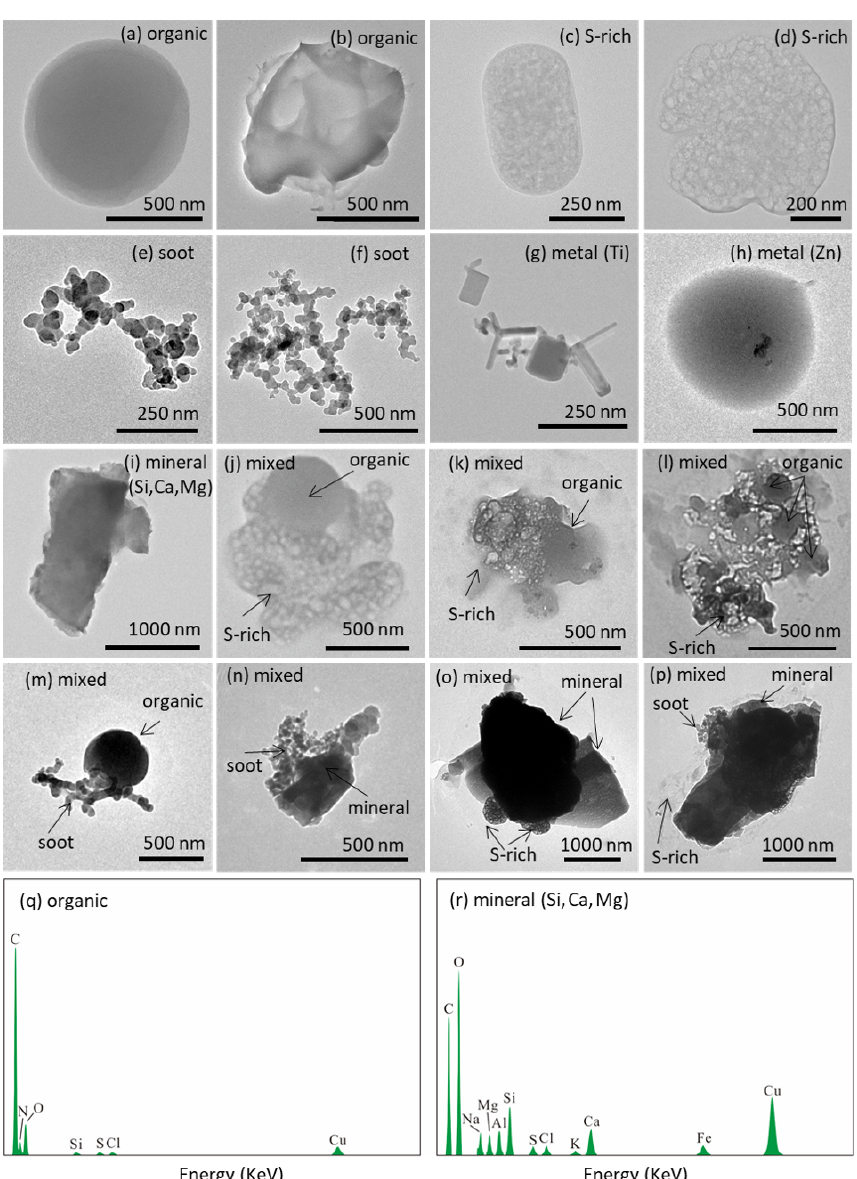
Figure 2. Examples of morphologies and mixing characteristics of individual aerosol particles in winter in Beijing at ground level and above the mixed layer. (a) Spherical organic particle, (b) irregularly shaped organic particle, (c–d) S-rich particles, (e–f) soot particles, (g–h) metal particles, (i) mineral particles, (j–l) OP–S mixed particles, and (m–p) other mixed-particle types. Panels (q) and (r) are EDS of (b) and (i) . The difference between the particles in (b) and (i) is that organic particles (b) are mainly composed of C and O, while minerals (i) are mainly composed of O, Si, Ca, and